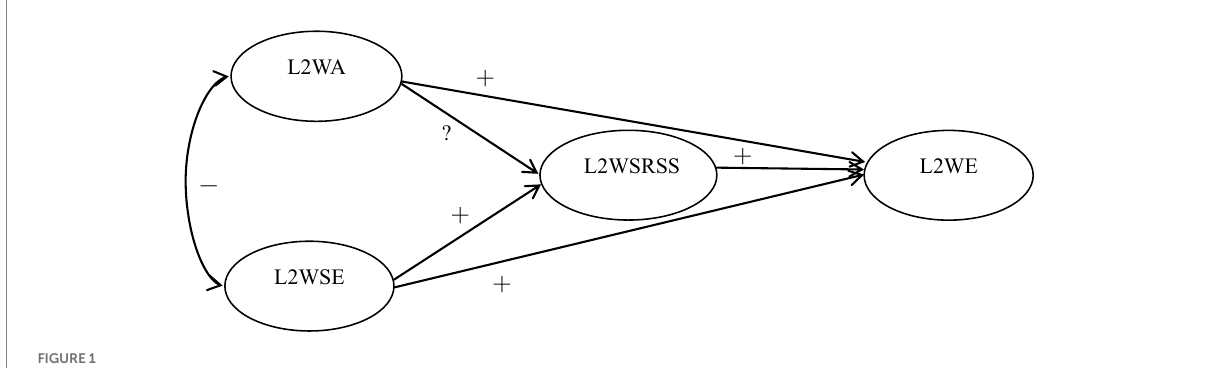
FIGURE 1 A hypothesized model of the relationship among the four